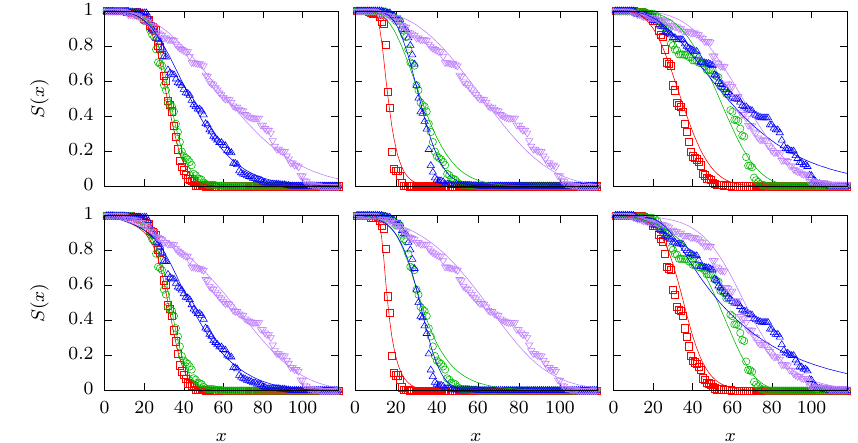
Figure A1. The upper row of panels shows the optimal fits for the quadruples 1000 – 1011 , 0010 – 1011 and 1010 – 1111 that are also displayed in the panels (a1), (b2) and (c3) of Figure 1. The lower row shows the corresponding optimal fits using the logistic function (A9) in conjuction with the same three CPs (CR, GM and GS).